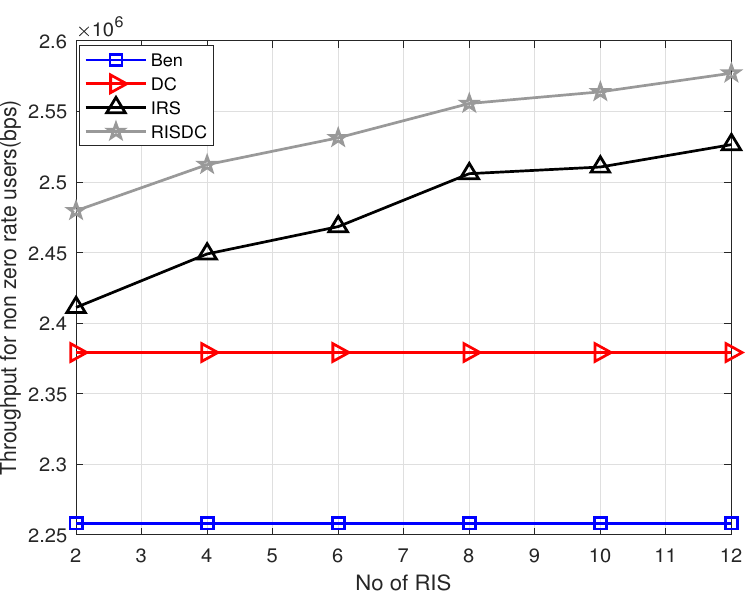
Figure 4. Variation of throughput of non-zero rate users (users only in coverage) with respect to number of RISs when ρ bs = 2, ρ user = 60, and µ b =